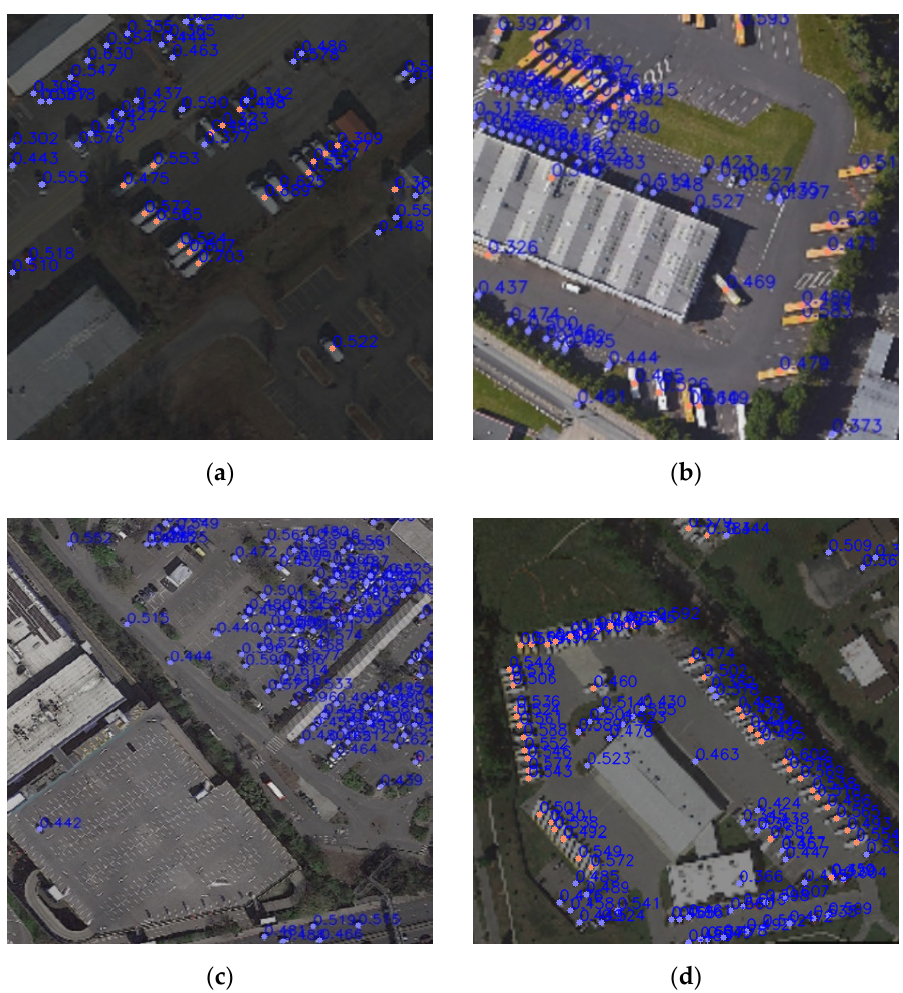
Figure 7. Examples of detection results. The two kinds of objects are represented by blue and orange dots respectively. ( a ) Example 1, ( b ) Example 2 ( c ) Example 3, ( d ) Example 4.